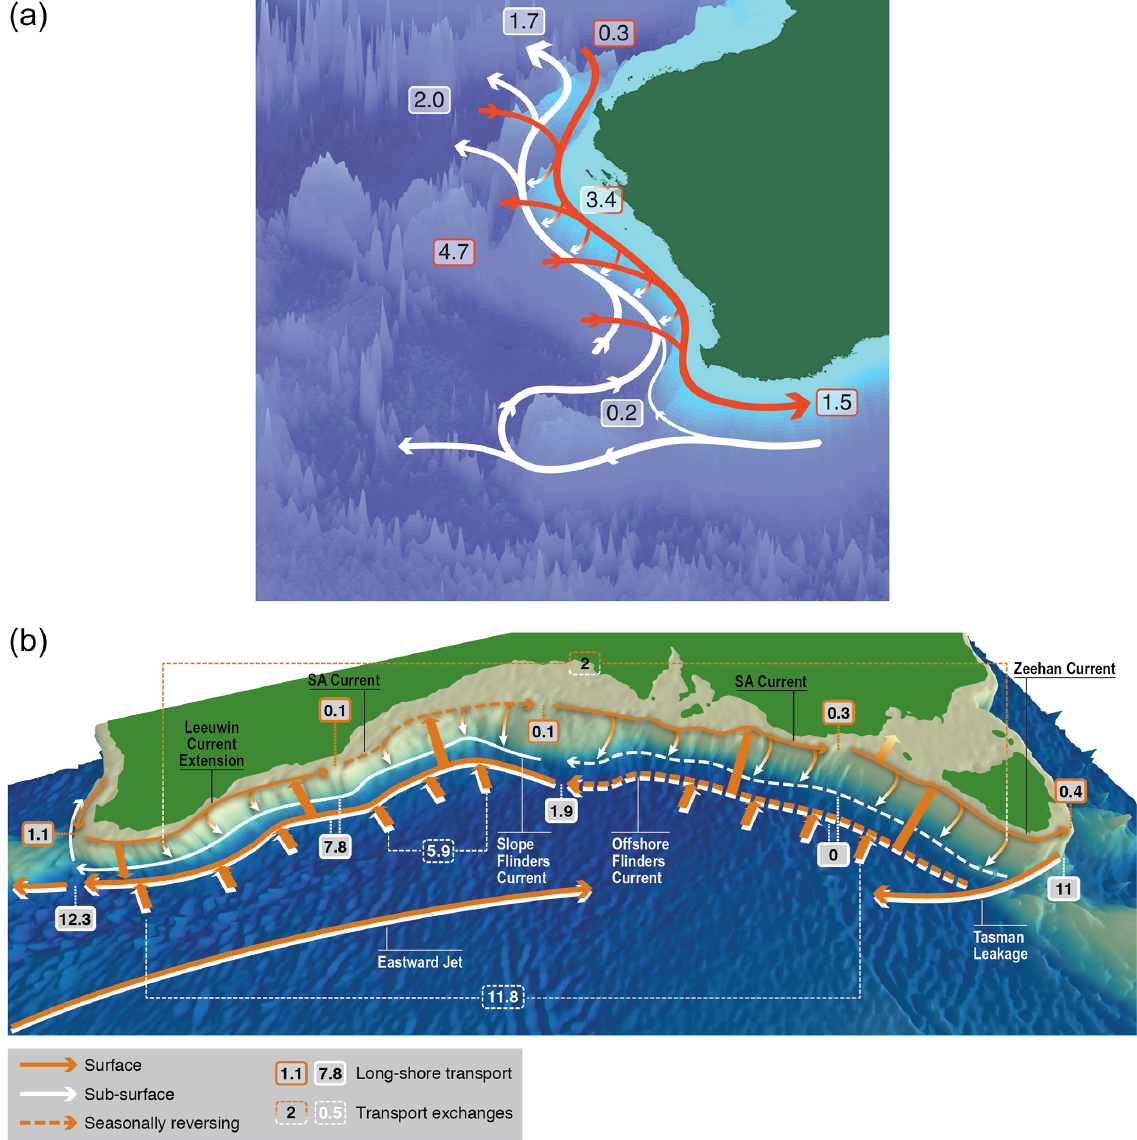
Figure 11. (a) Schematic summary of Australia’s Leeuwin Current System three-dimensional transports (Sv). The red arrows and red- outlined numbers represent the upper-layer (0–200m) meridional transport of the poleward Leeuwin Current and meridionally integrated zonal transport of the shallow eastward flows. The white arrows represent the lower-layer (200–900m) flows of the Leeuwin Undercurrent. Taken from Furue et al. (2017). © American Meteorological Society. Used with permission. (b) Schematic summary of the Southern Australia Current System three-dimensional transports (Sv). Long-shore transport for the Shelf-Break Currents and Flinders Current in grey box with orange and white outlines, respectively. Integrated vertical and onshore flow transport in dashed outline box. Reprinted from Duran et al. (2020), with permission from Elsevier, Progress in Oceanography. Both schematics are based on a geostrophic calculation in the CARS 1 / 8 ◦